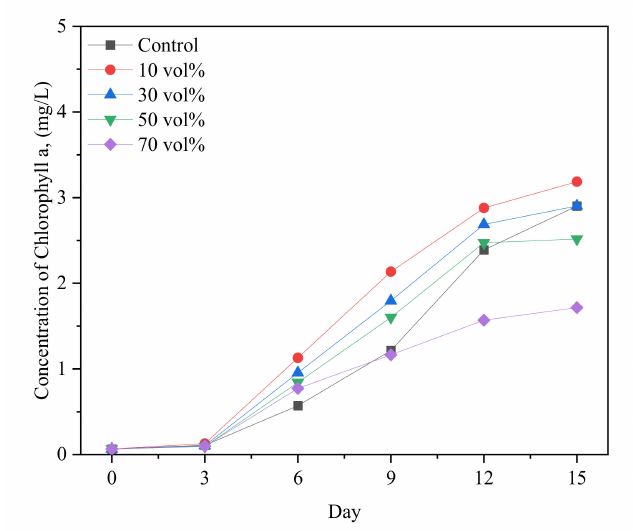
Figure 3. Effects of various additions (vol%) of EAF slag leaching solution on concentration of chlorophyll a